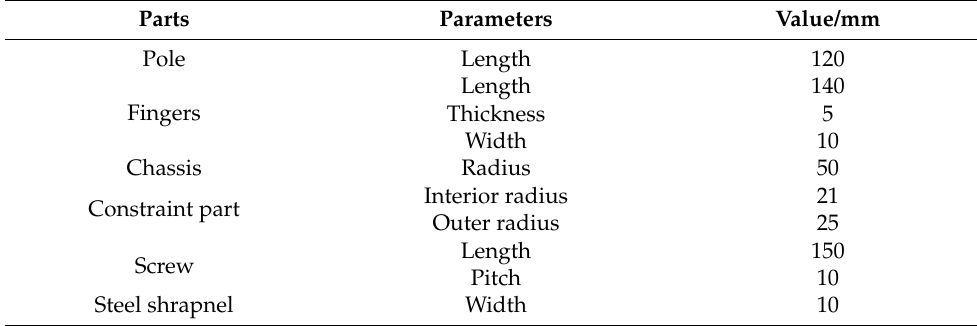
Table 1. The table of the key parts